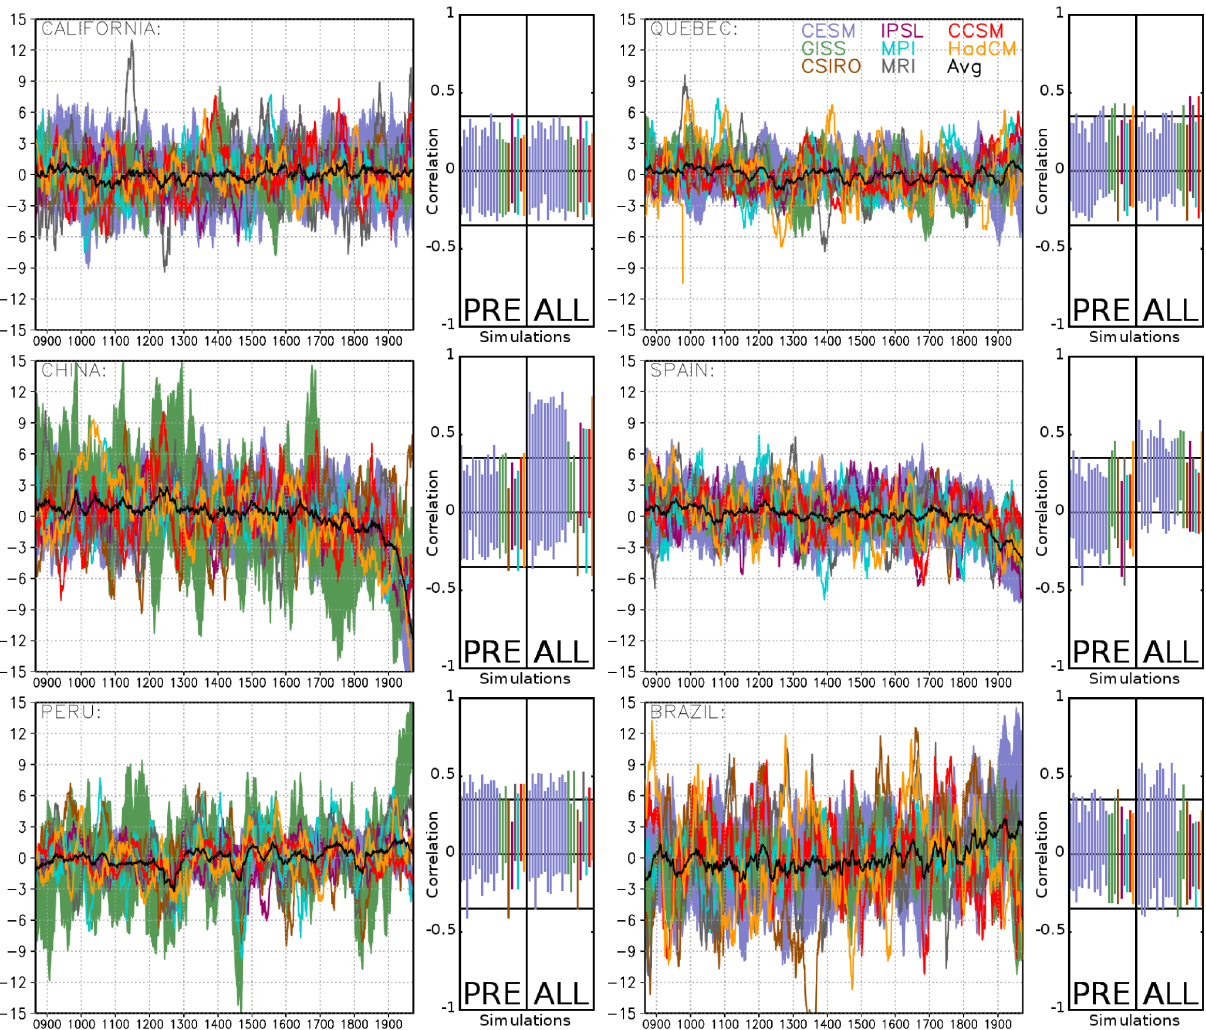
Figure 14. Time series of precipitation in millimeters per month for some particular case example locations. The range of correlations between the time series of each simulation and those of other simulations at those specific locations is also included both for the whole period (right; ALL) and for the preindustrial era (left; PRE). For these correlations, the significance level ( p < 0 . 05) accounting for autocorrelation is shown with a black line. All precipitation series have been 31-year low-pass filtered with a centered moving